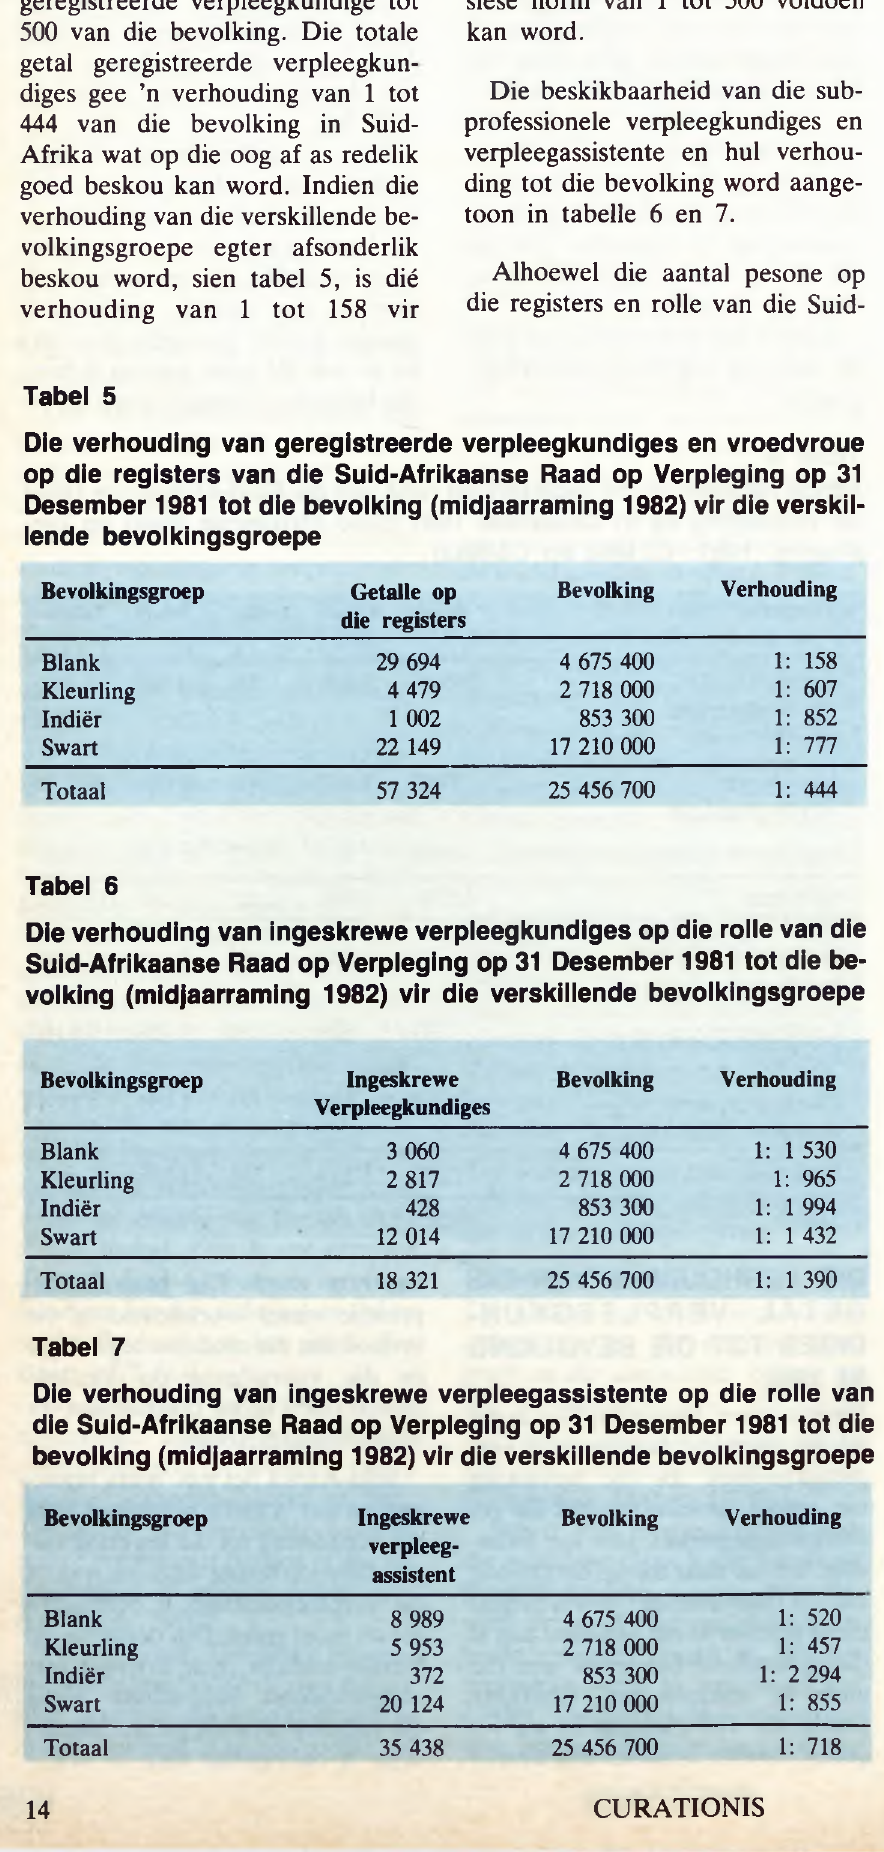
Die verhouding van ingeskrewe verpleegassistente op die rolle